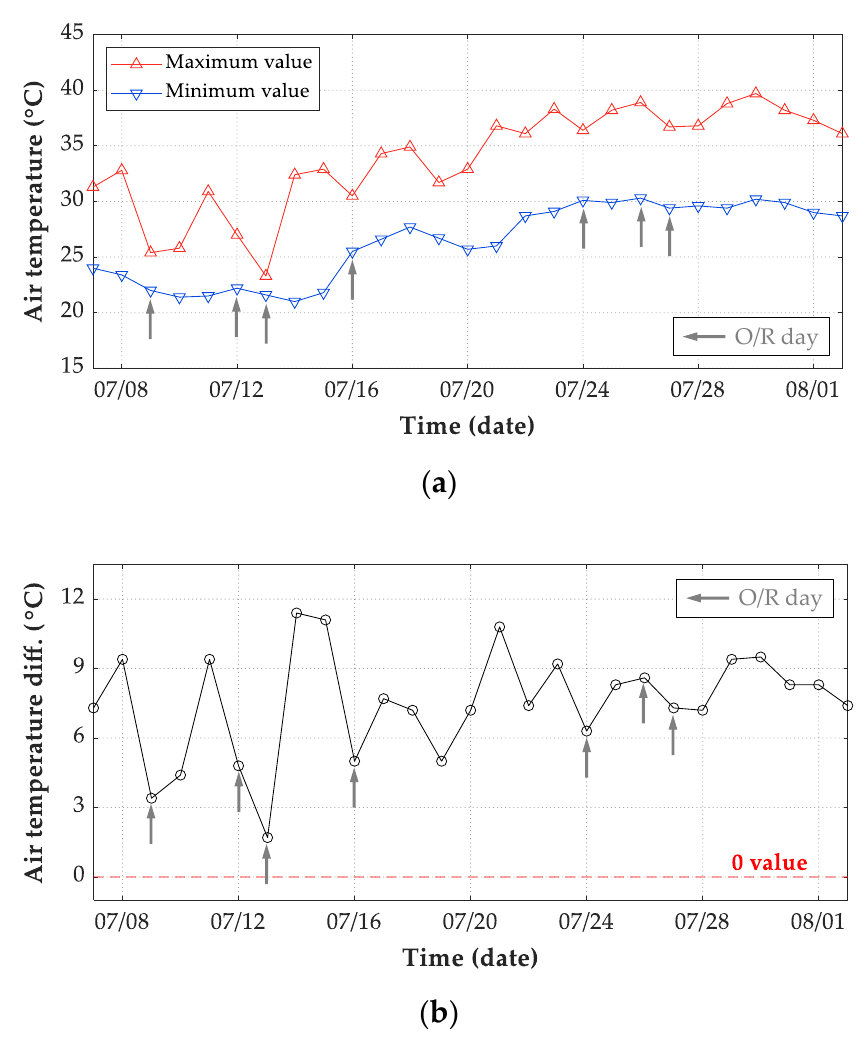
Figure 14. Daily air temperature records from 7 July 2019 to 2 August 2019. ( a ) Daily maximum and